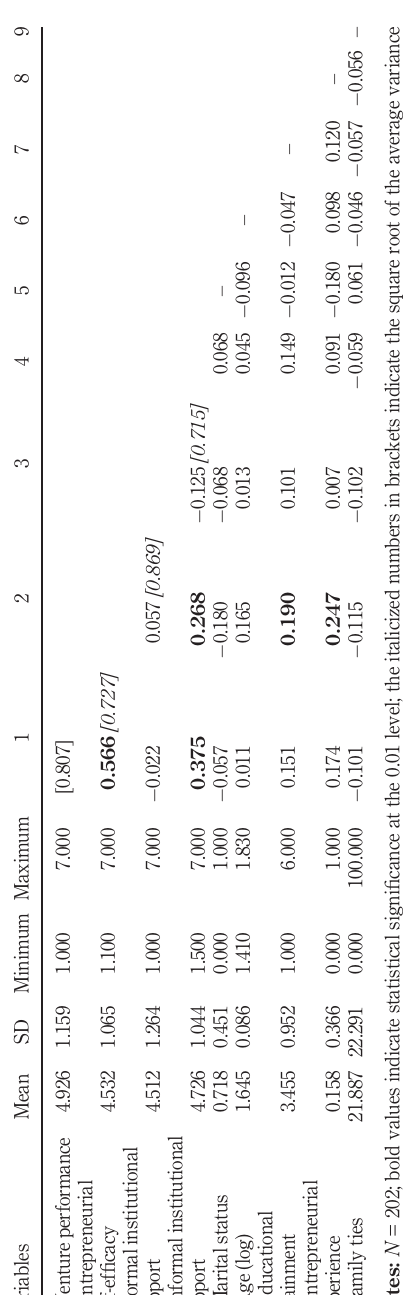
Table II. Descriptive statistics and correlation